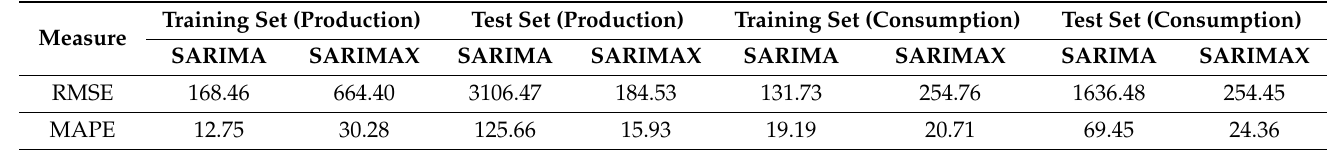
Figure 7. Forecast visualization of natural gas production and consumption with SARIMAX and SARIMA models with SARIMA models with selected exogenous factors for the test set. selected exogenous factors for the test set. Table 6. The performances metrics of the models SARIMA and Table 6. The performances metrics of the models SARIMA and SARIMAX.